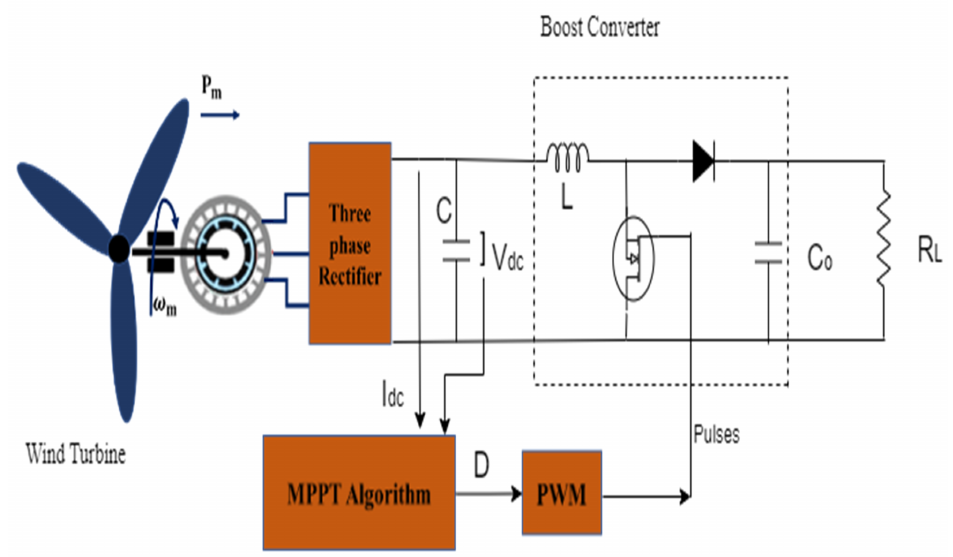
Figure 1. Overall power system. The mechanical power is represented by P m and ω m is the angular speed in rad/s. C represents the input capacitor of the boost converter, I dc and V dc represent the rectified current and voltage, L is the boost converter inductor, C o is the output capacitor of the boost converter stage. The duty cycle D is the output from the MPPT algorithm block. R L is the load